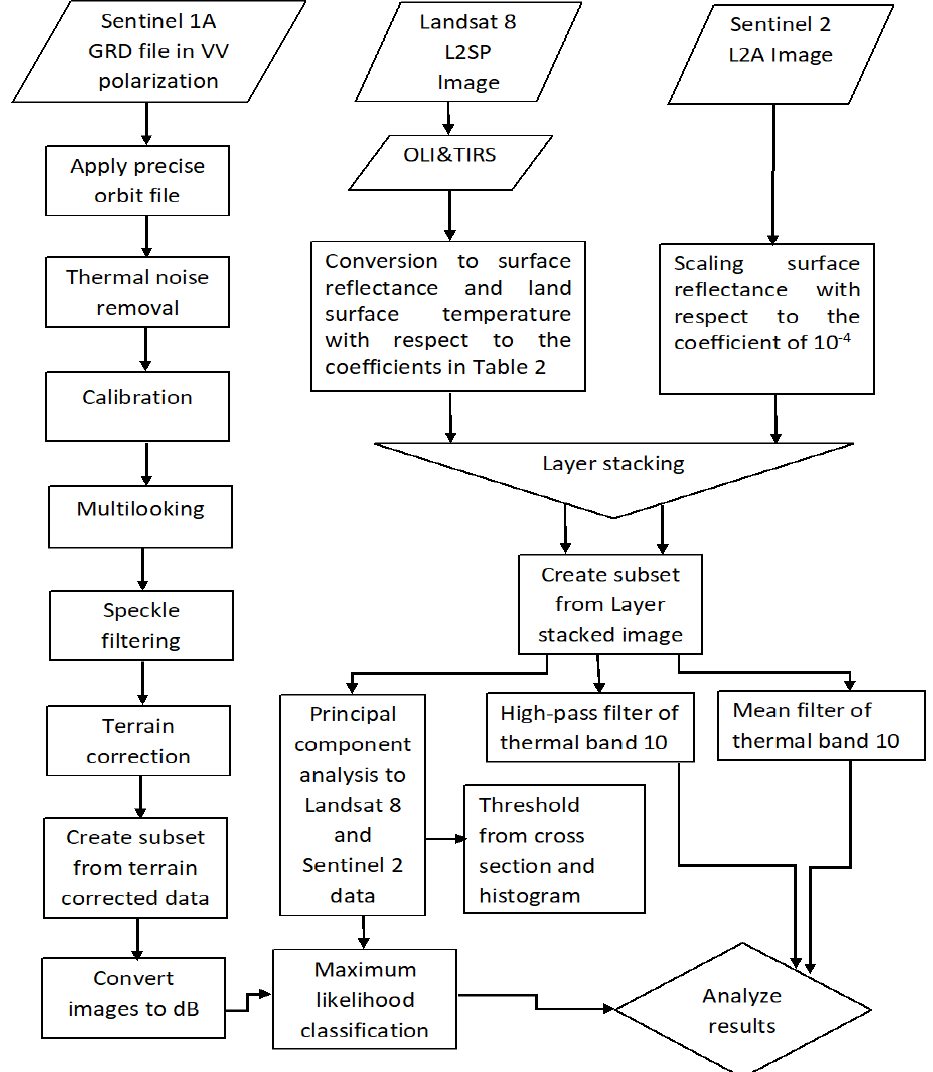
Figure 2. The workflow used in the study.